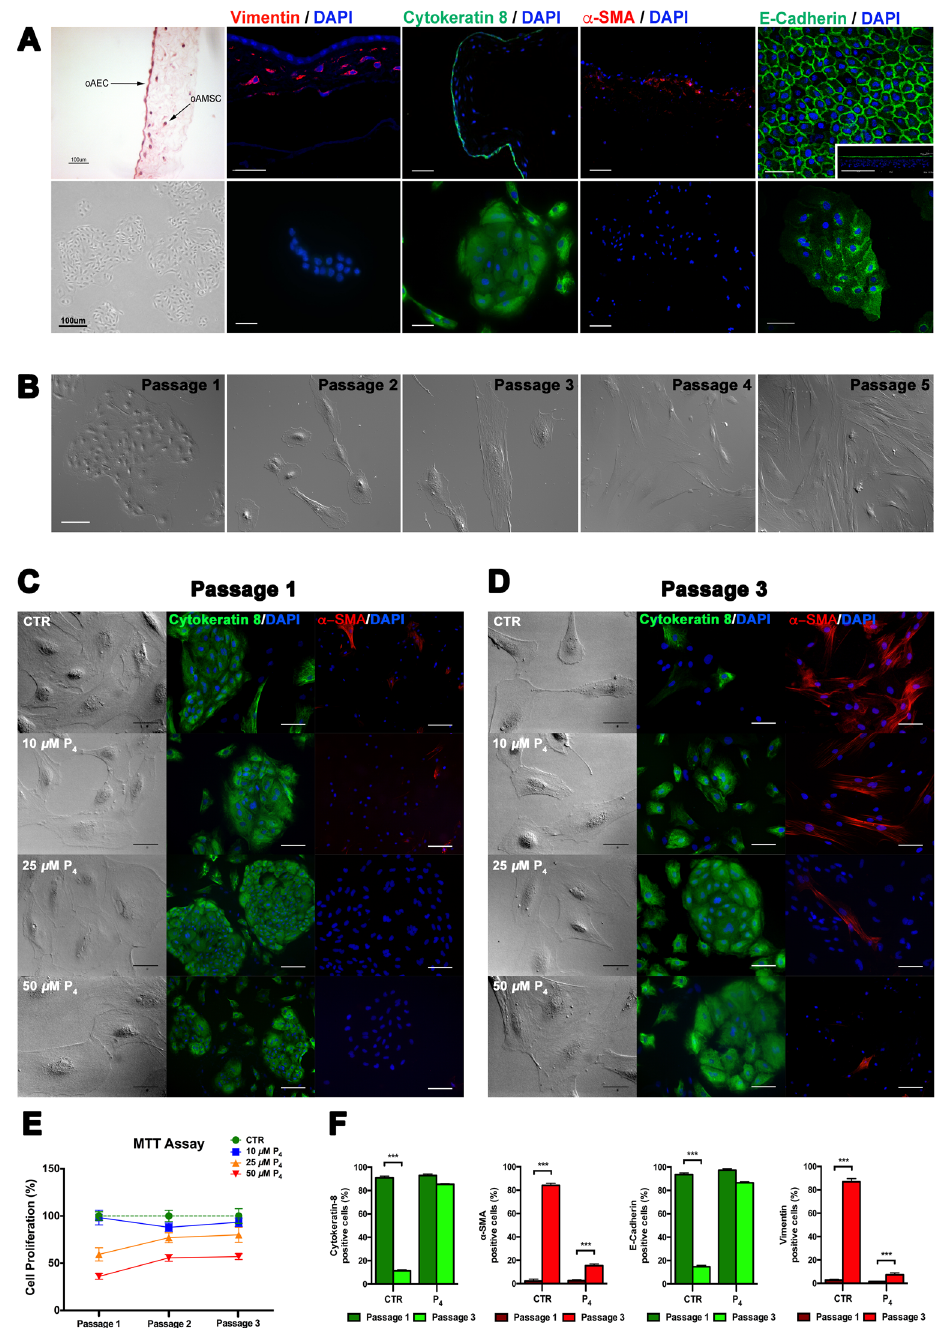
Figure 1. P 4 prevents the in vitro EMT of oAEC. ( A ) Hematoxylin/eosin staining of amniotic membrane (AM) and phase contrast images of freshly-isolated oAEC show the same epithelial morphology. Scale bar: 100 µ m. Immunostaining for epithelial (Cytokeratin-8, E-Cadherin) and mesenchymal ( α -SMA, Vimentin) markers in AM and freshly-isolated oAEC show the same expression pattern. Magnification 20x (AM Cytokeratin-8, α -SMA; oAEC α -SMA). Scale bar: 100 µ m Magnification 40x (AM Vimentin, E-Cadherin; oAEC Vimentin, Cytokeratyn-8, E-Cadherin). Scale bar: 50 µ m. ( B ) Morphology of oAEC in different passages. Scale bar: 50 μ m. ( C ) Phase contrast images of CTR and P 4 -treated oAEC morphology. Scale bar: 25 µ m. Immunocytochemistry for Cytokeratin-8 and α -SMA, at passage 1. Scale bar: 100 µ m. ( D ) Phase contrast images of CTR and P 4 -treated oAEC morphology. Scale bar: 25 µ m. Immunocytochemistry for Cytokeratin-8 and α -SMA, at passage 3. Scale bar: 50 µ m. ( E ) Cell proliferation of CTR and P 4 -treated oAEC, during three passages. Data are expressed as percentage of proliferation ± SD, from n = 3 independent experiments performed in triplicate, with CTR set to 100%. ( F ) Fluorescence quantification of Cytokeratin-8, α -SMA, E-Cadherin and Vimentin protein expression in CTR and P 4 -treated oAEC, at passage 1 and 3. *** p < 0.001. Abbreviation: oAEC, ovine amniotic epithelial cells; oAMSC, ovine amniotic mesenchymal stem cells; CTR, control cell; P 4 ,